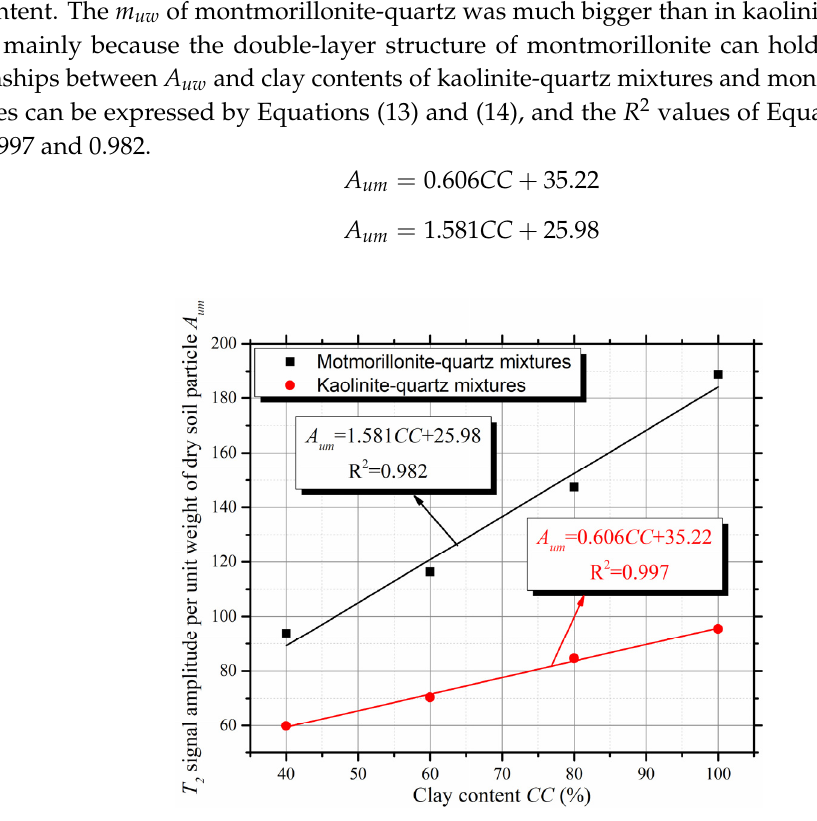
Figure 4. The relationship between the T 2 signal amplitude per unit weight of dry soil particles ( A um ) and clay content ( CC ). The lines at the top and bottom indicate the relationships between the A um and CC of montmorillonite-quartz and kaolinite-quartz mixtures, respectively. The Equations in the two boxes are the Equations of the two lines. R 2 indicates the correlation coefficient of the Equation.